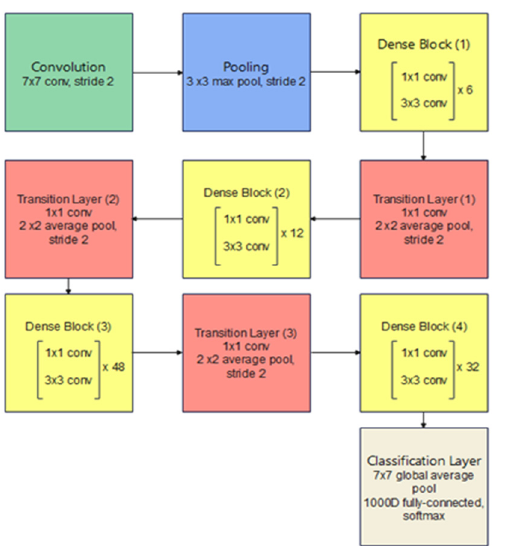
Figure 7. DenseNet-201 architecture, every convolutional layer corresponds to the series BN-ReLU- Conv.